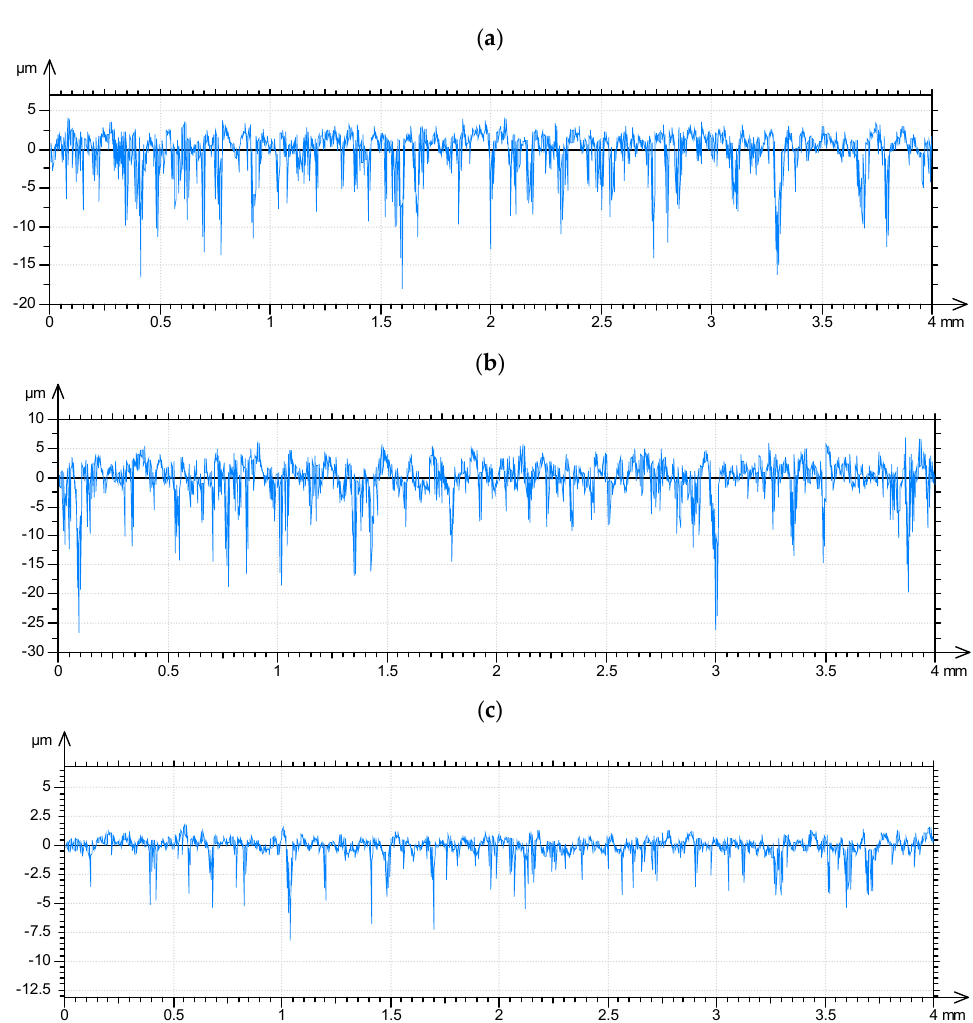
Figure 14. Two process random profiles: Rpq = 1 µm, Rvq = 7 µm, Rmq = 70%, Rq = 2.88 µm, Rqpr = 2.8 µm ( a ), Rpq = 2 µm, Rvq = 10 µm, Rmq = 80%, Rq = 3.69 µm, Rqpr = 3.6 µm ( b ) Rpq = 0.5 µm, Rvq = 5 µm, Rmq = 90%, Rq = 0.955 µm, Rqpr = 0.95 µm ( c ), the correlation lengths of the plateau and valley profiles were 20 µm.